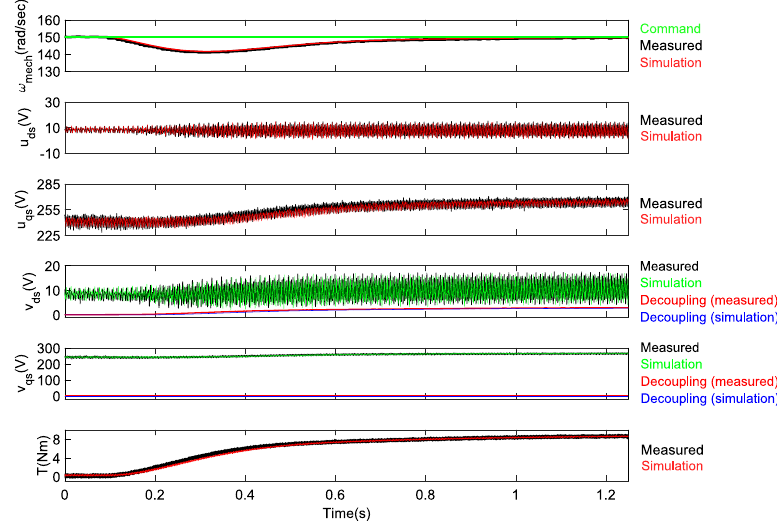
Figure 19. Flux and torque decoupling terms behavior.